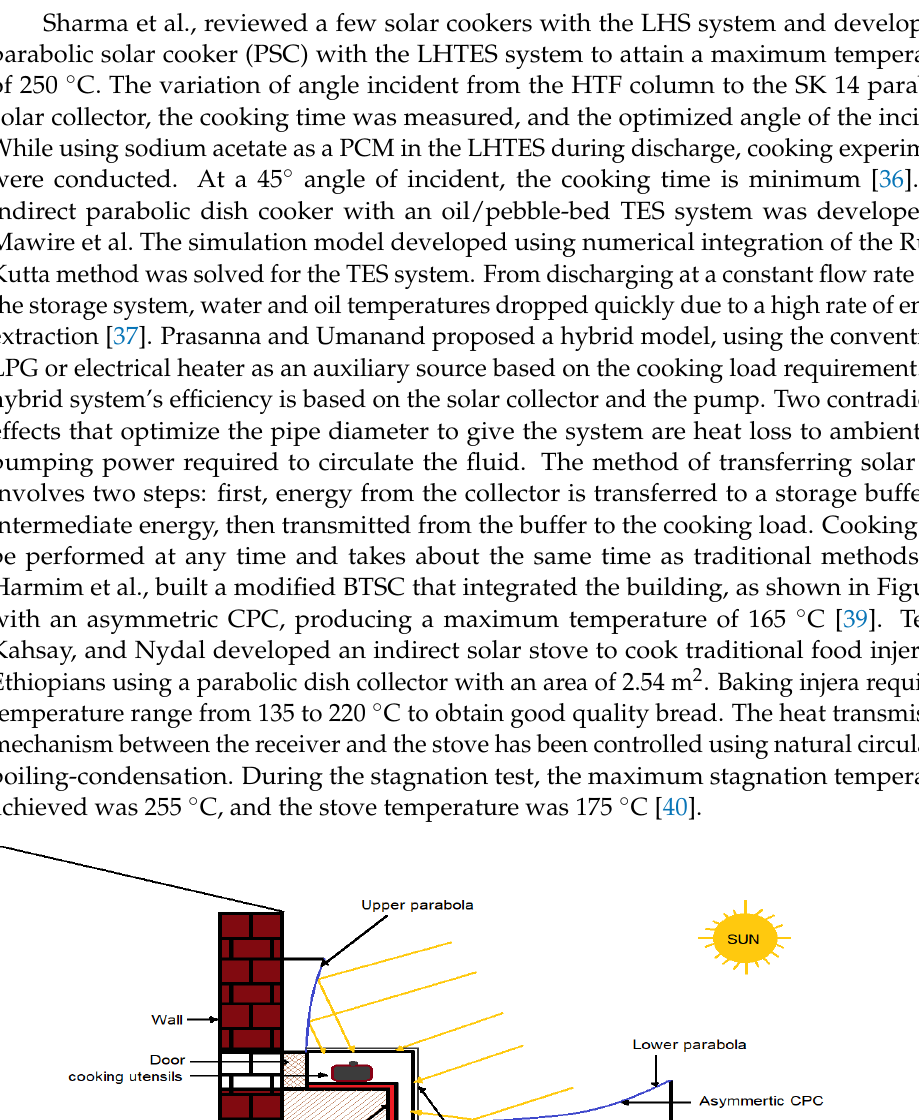
Figure 1. Wickless heat pipes flat solar plate collector with an indoor cooking unit. Reprinted/adapted with permission from (2008), Hussein et al. [35].